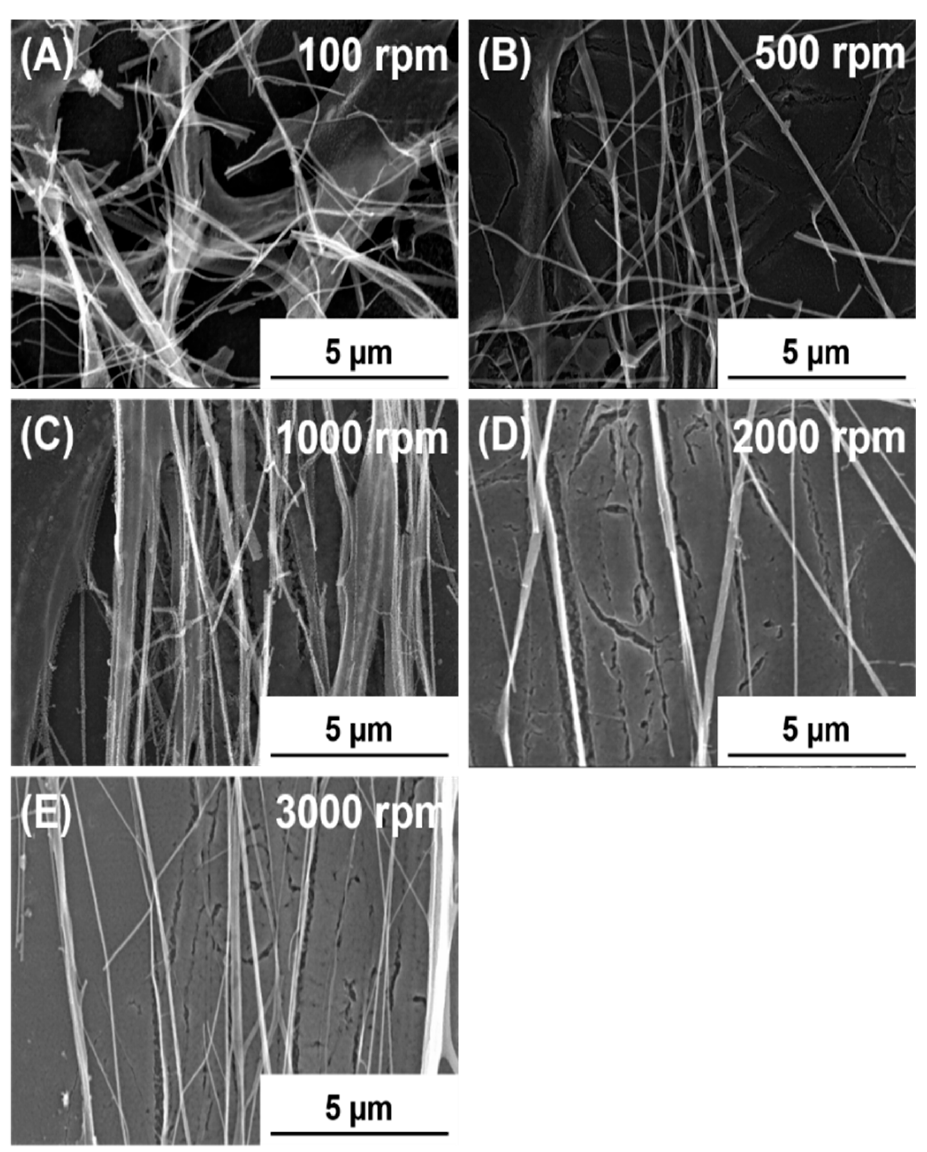
Figure 4. FE-SEM morphology analysis of CuCrO 2 thin films deposited on glass substrates at different rotating speed and annealed at 600 °C. Speed of rotation: ( A ) 100 rpm, ( B ) 500 rpm, ( C ) 1000 rpm, ( D ) 2000 rpm, ( E ) 3000 rpm.